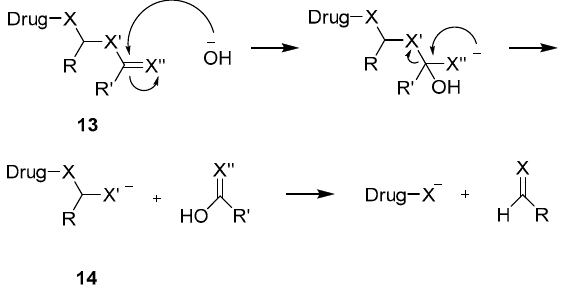
Figure 4. Mechanism for reversion of a soft alkyl derivative of an acidic functional group in a drug molecule.